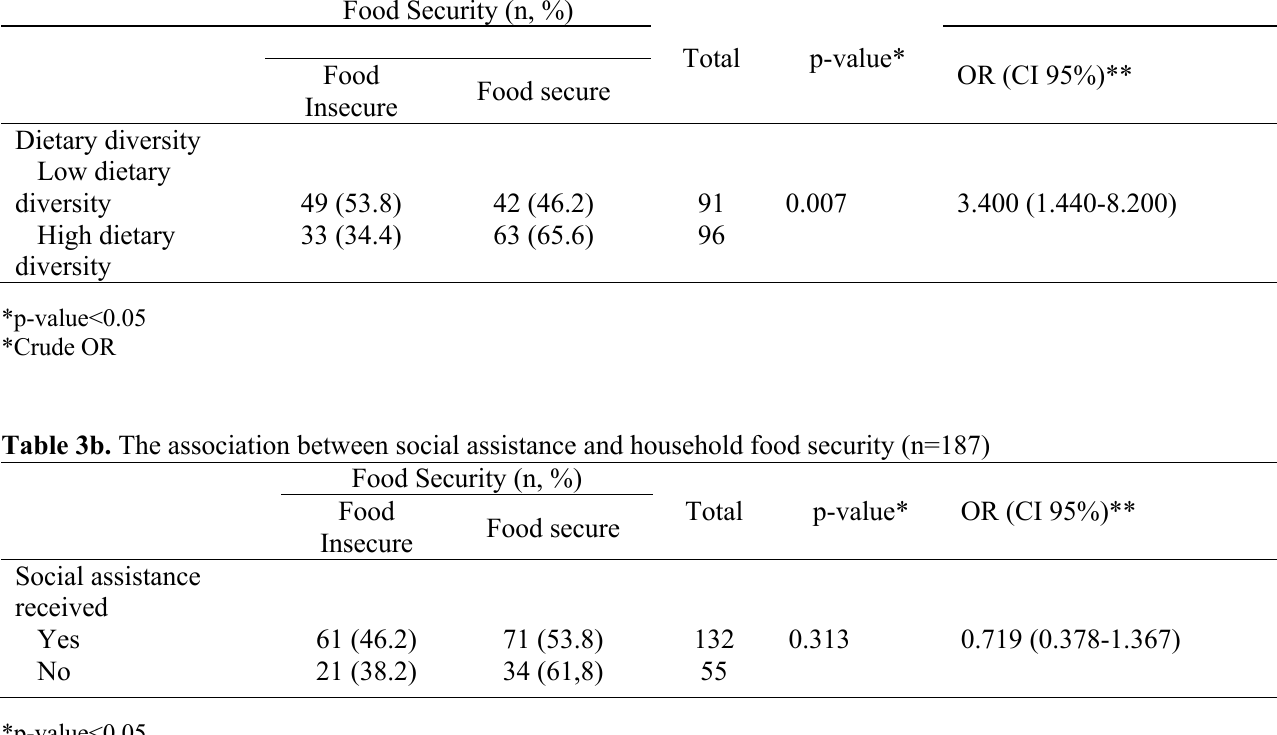
Table 3a. The association between dietary diversity and household food security (n=187)